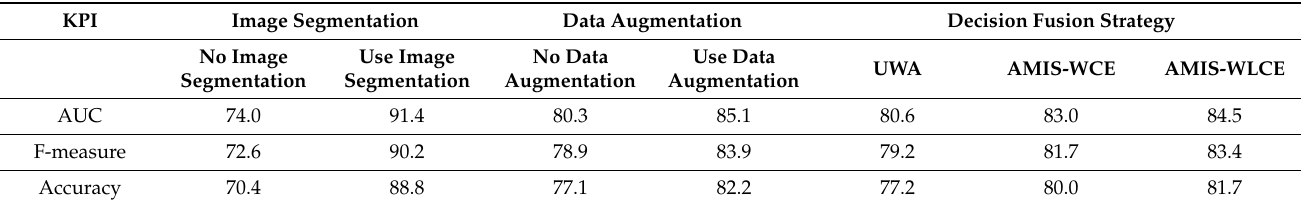
Table 2. Average AUC, F-Measure, and Accuracy of the Proposed Models.